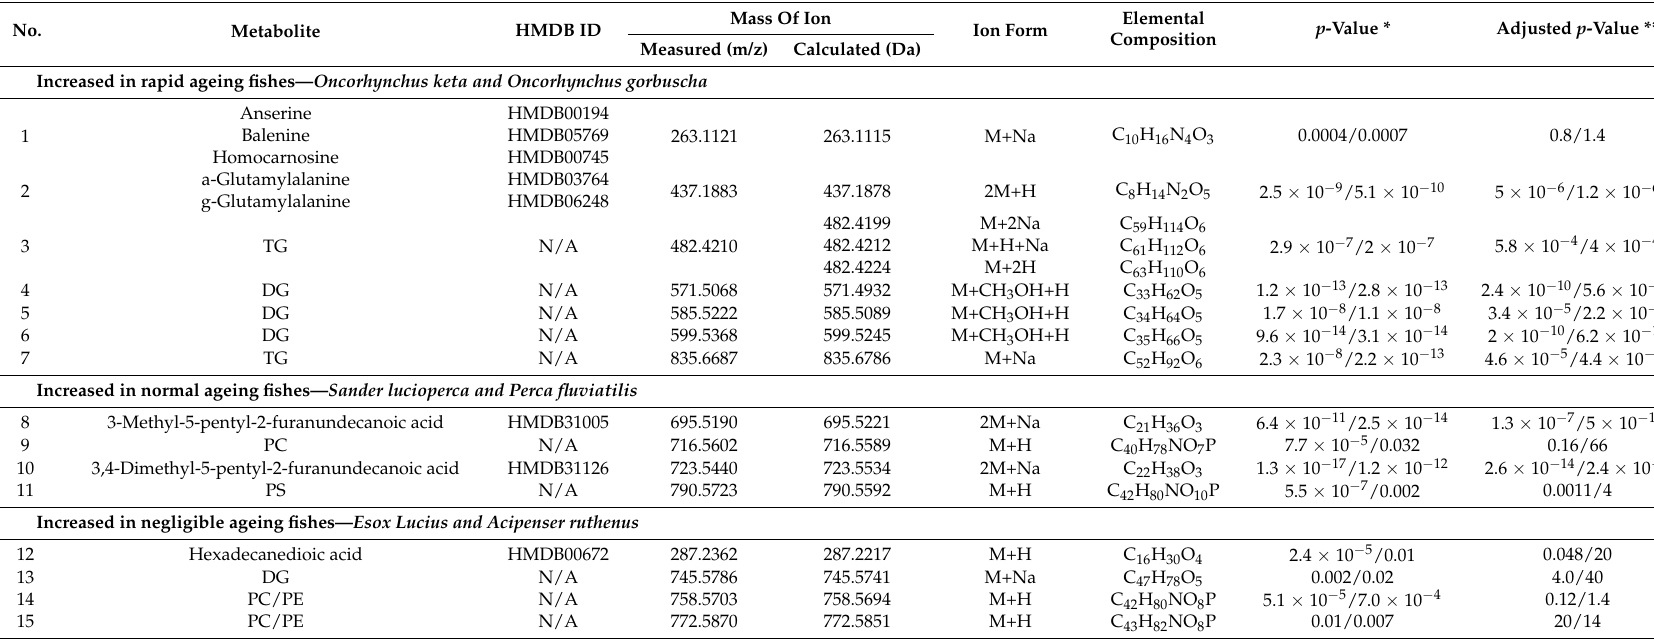
Elemental Mass Of Ion p -Value * Adjusted p -Value ** Ion Form Composition Measured (m/z) Calculated (Da)